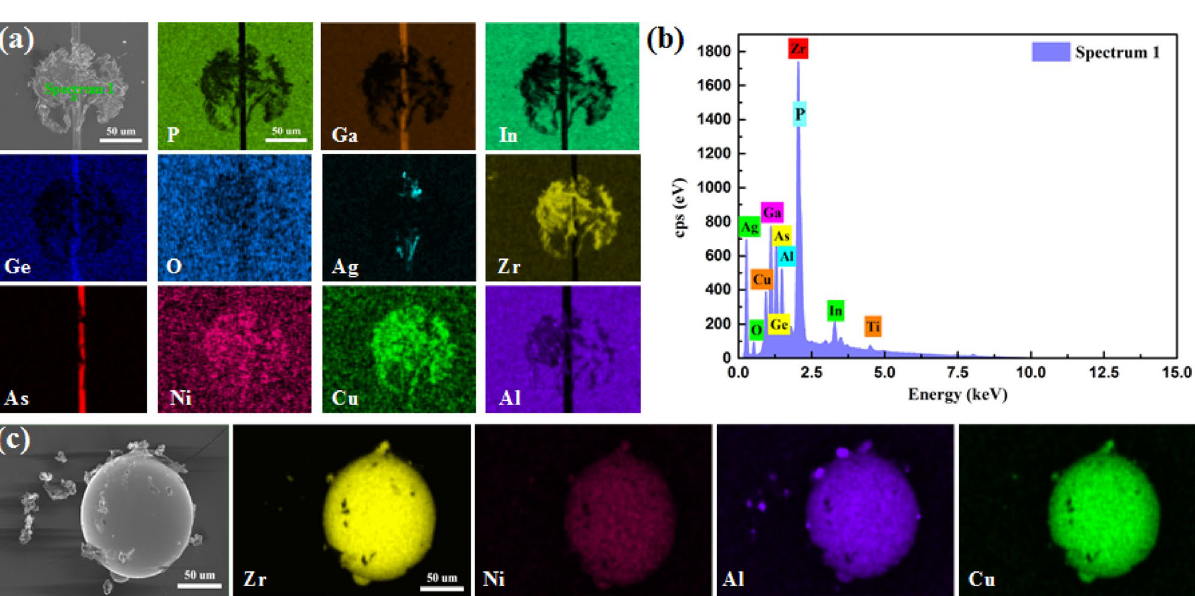
Figure 7. EDS mapping results. ( a ) PV cell after impact. ( b ) Distribution of elements in the PV cell sample after impact. ( c ) Distribution of elements in original amorphous alloy